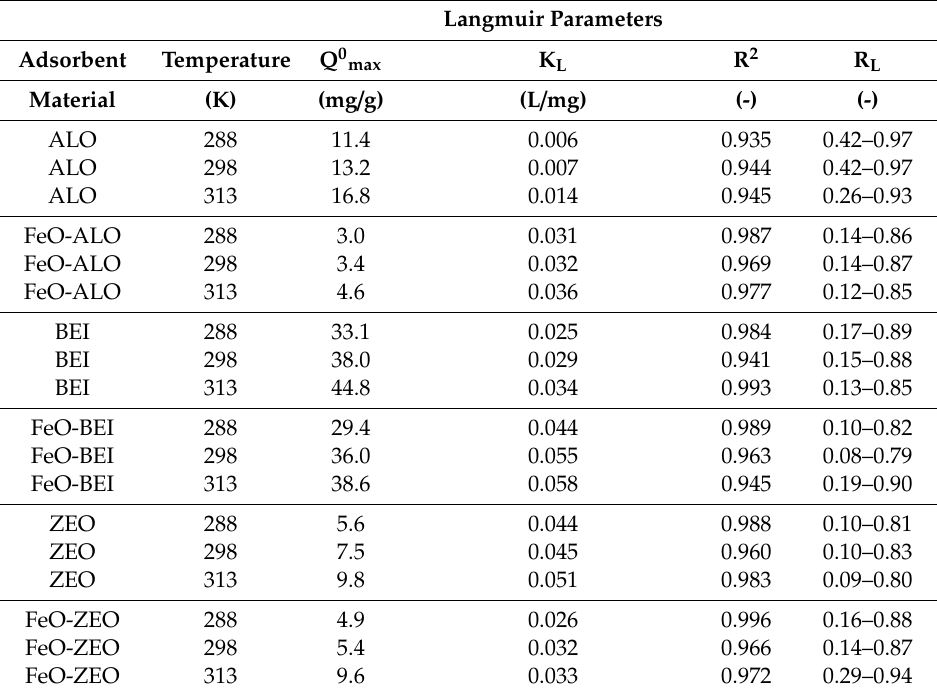
Table 4. Summary of the Langmuir isotherm parameters and separation factors (R L ) for the adsorption of aqueous Ba 2 + by ALO, BEI and ZEO with (out) FeO-modification.